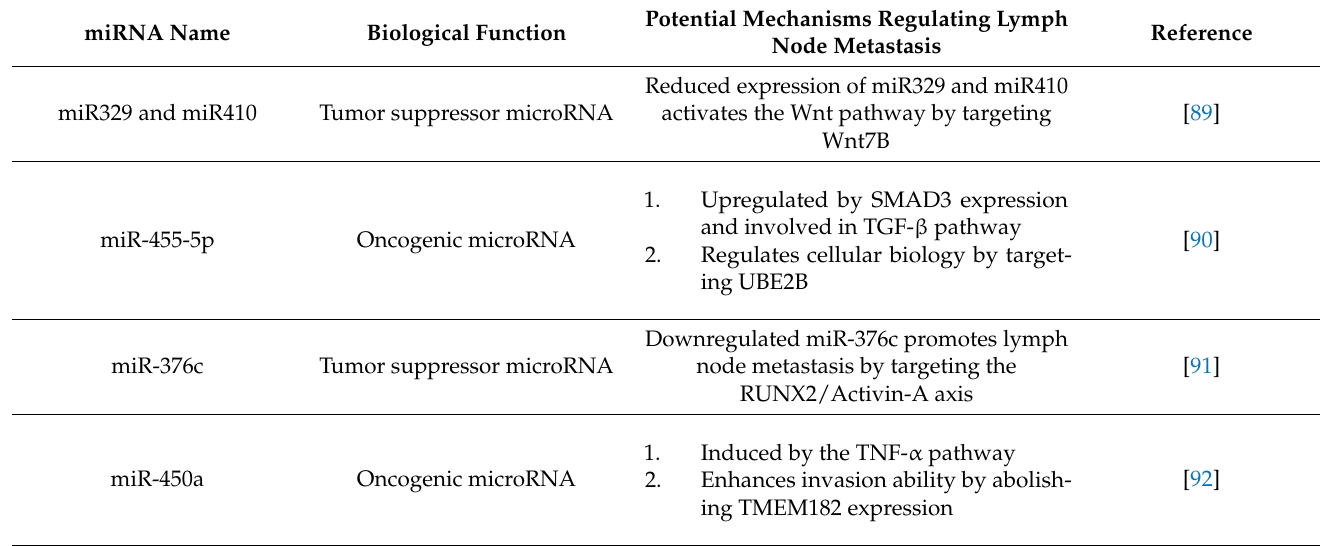
Table 4. Major miRNAs involved in lymph node metastasis in Taiwanese patients with oral